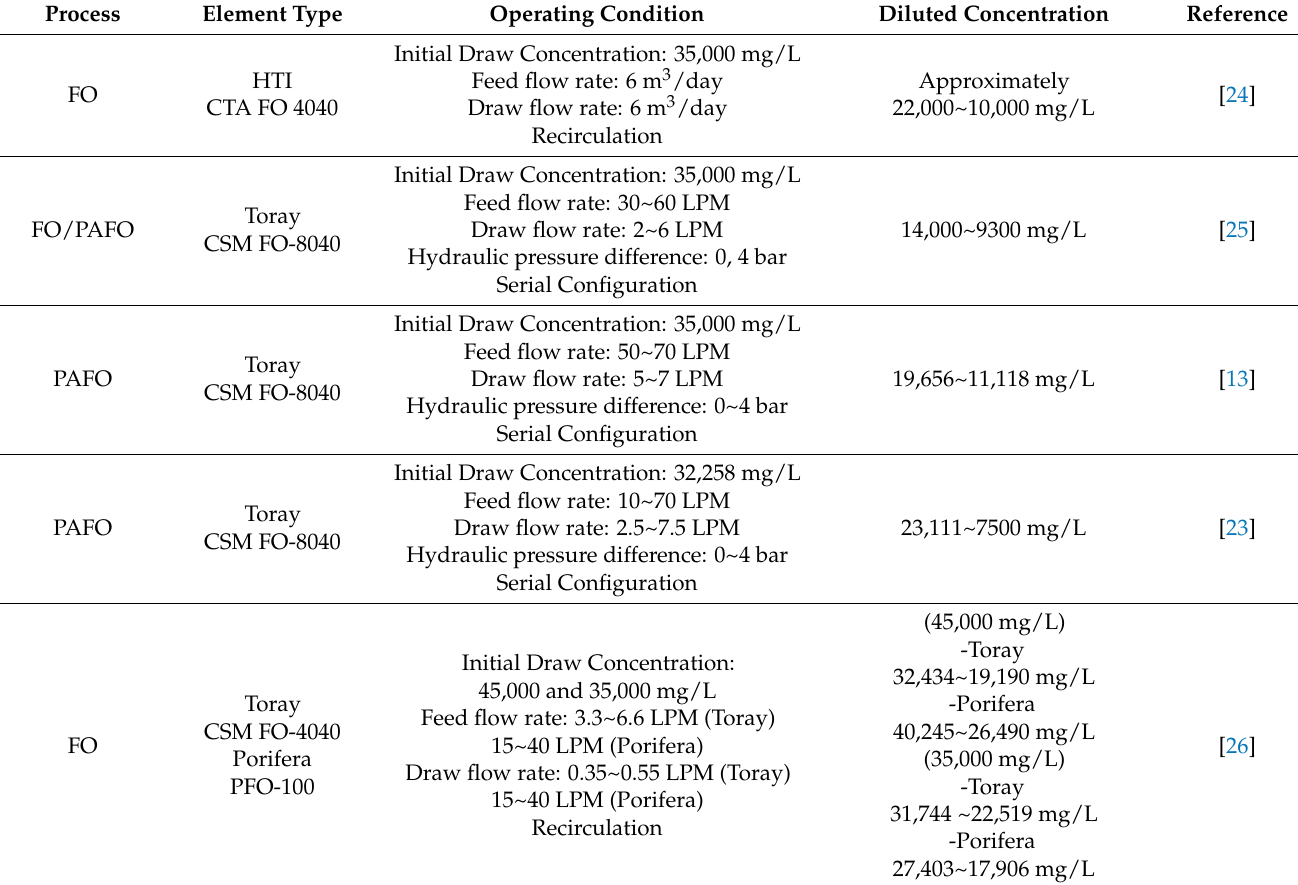
Table 3. List of diluted concentration in pilot studies of the wastewater–seawater (WW-SW) integrated RO process with operating condition and membrane types.